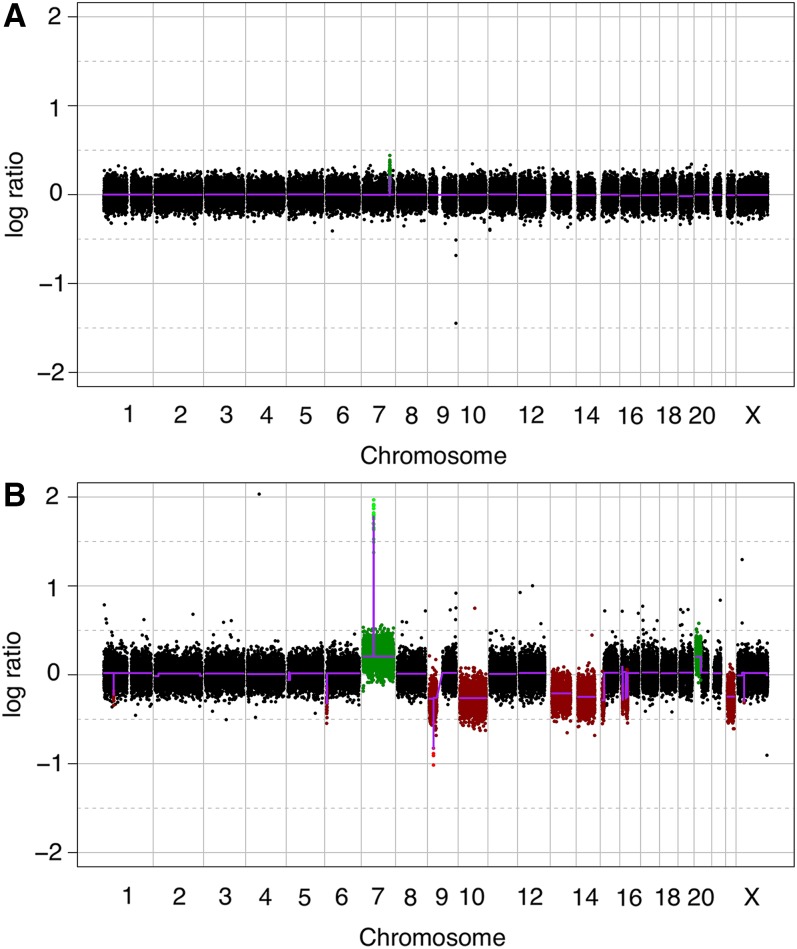
Plots representing the whole genome of (A) pilocytic astrocytoma and (B) glioblastoma.